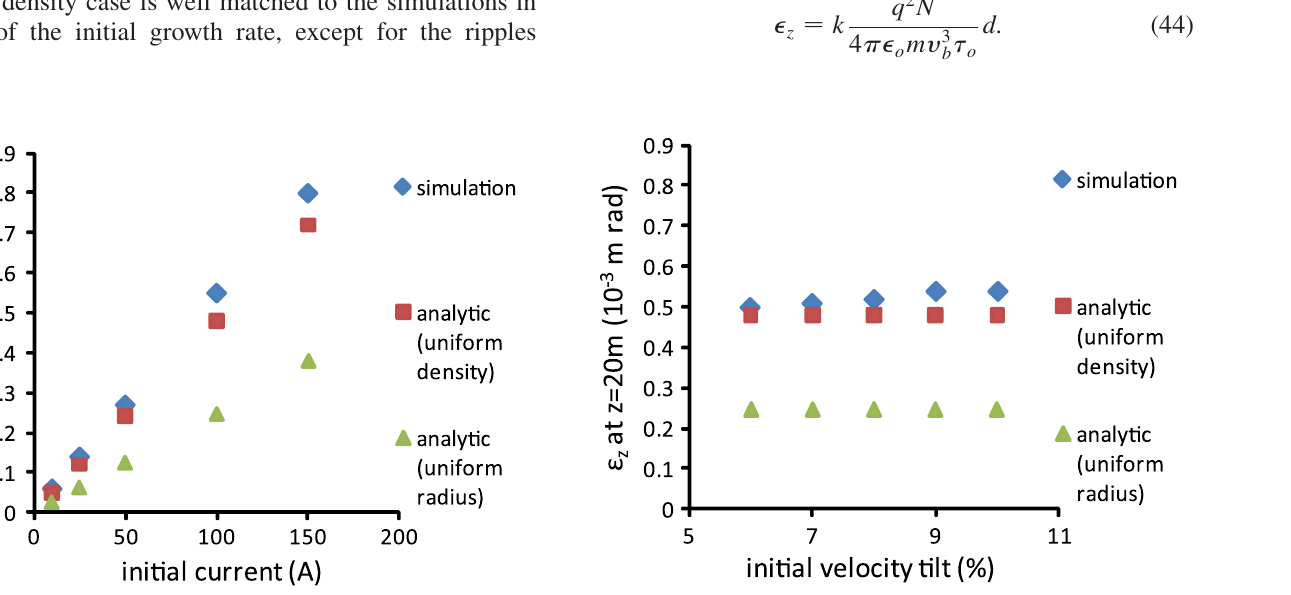
FIG. 17. z emittance at z ¼ 20 m ( (cid:1) 10 (cid:2) 3 ) vs initial current, showing 2 cases with uniform beam radius (green), uniform charge density (red), and WARP simulation (blue).